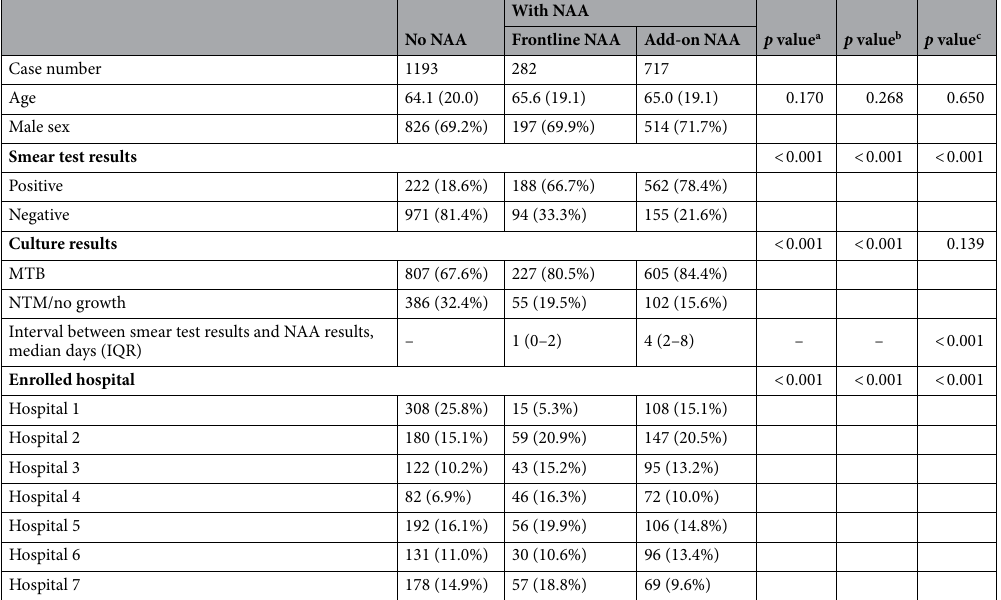
Table 1. Characteristics of active pulmonary TB patients with and without NAA test. Data are presented as n (%) unless otherwise mentioned. NAA nucleic acid amplification, TB tuberculosis, MTB Mycobacterium tuberculosis. a Comparison between patients with frontline NAA and no NAA test. b Comparison between patients with add-on NAA and no NAA test. c Comparison between patients with frontline and add-on NAA